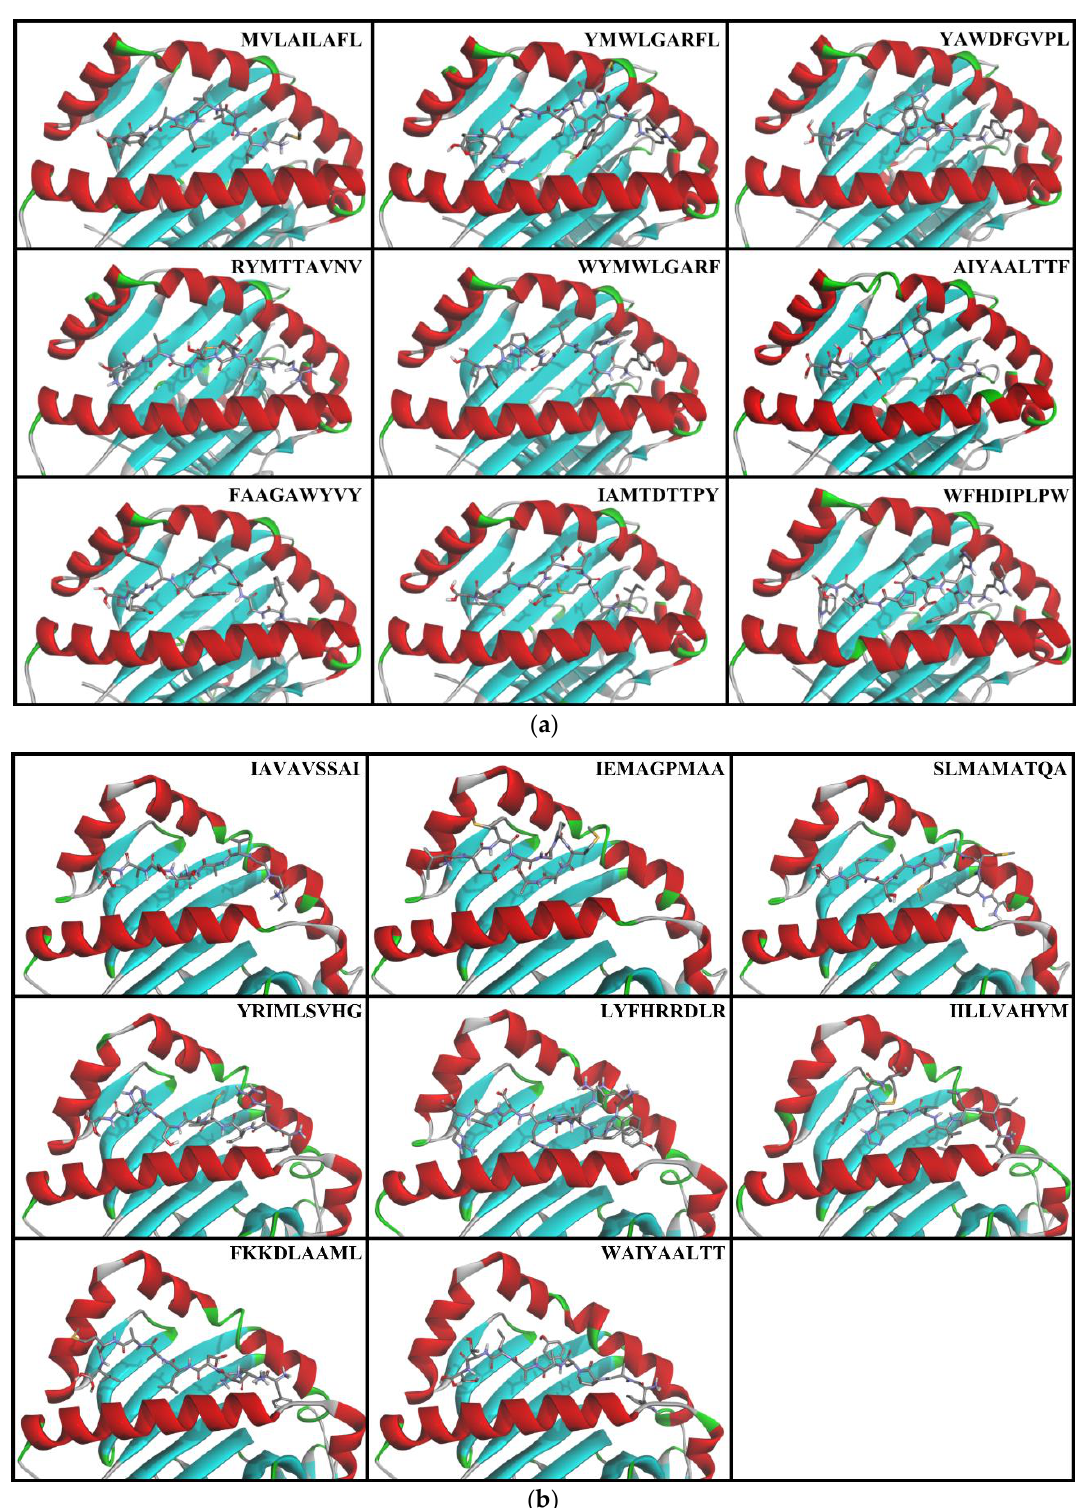
Figure 1. Conformations of epitopes when docked to a strongly binding HLA. ( a ) MHC-I epitopes; ( b ) MHC-II epitopes. Table 4. Summary of docking results of epitope with MHC-I.